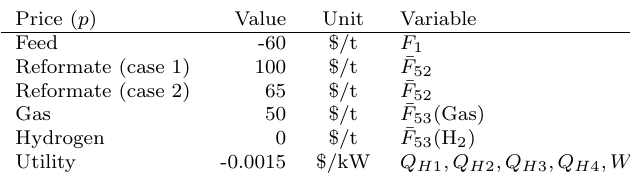
Table 7: Economy